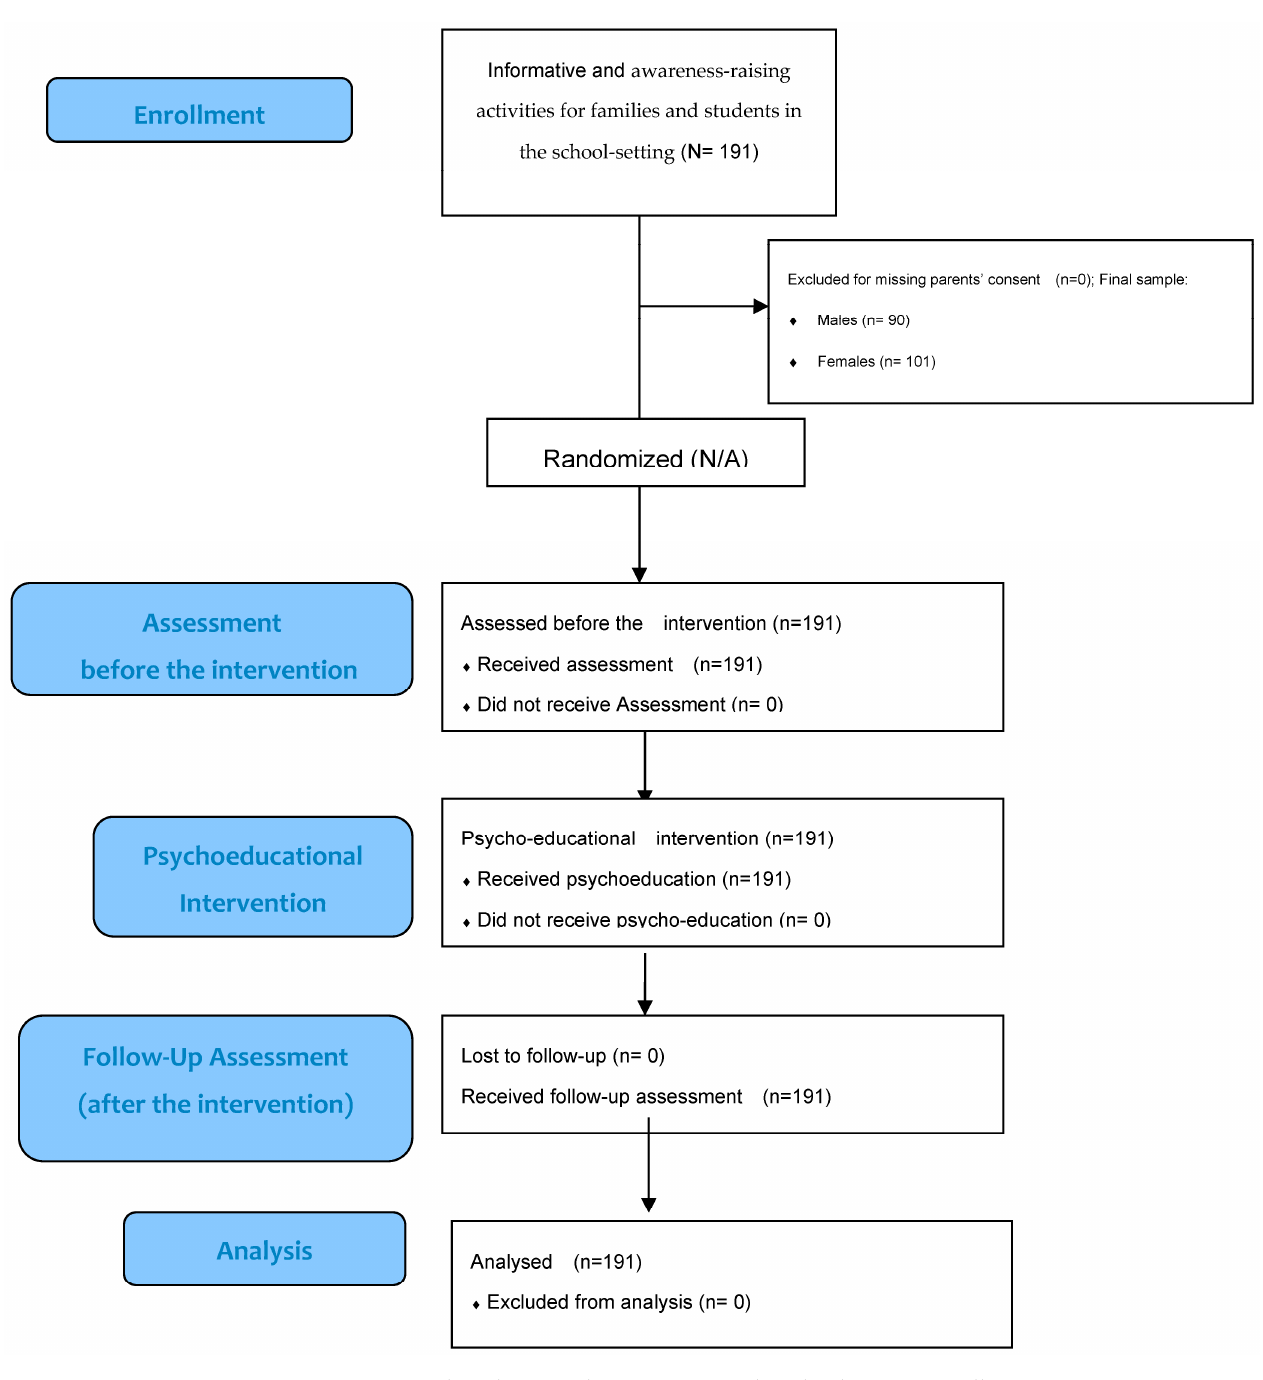
Figure 1. Psycho-educational intervention in the school setting: enrollment, assessment, intervention, follow-up, and analysis [CONSORT (2010) flow diagram ] .